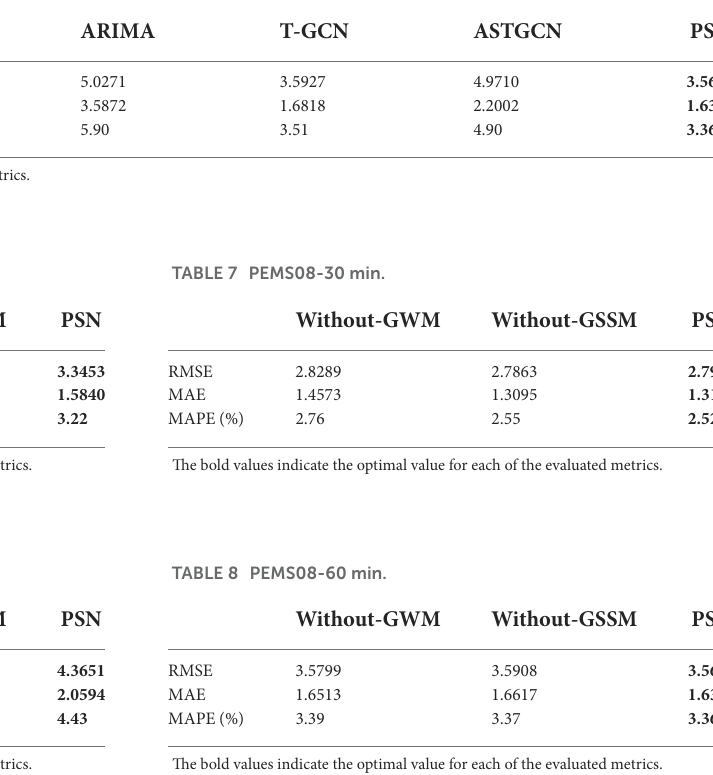
TABLE 4 PEMS08-60 min.